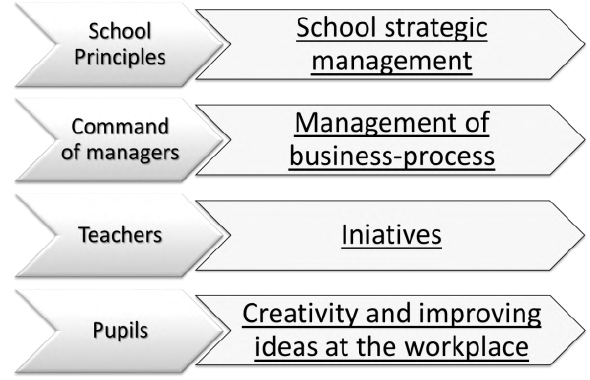
Figure 32: Presentation of paper